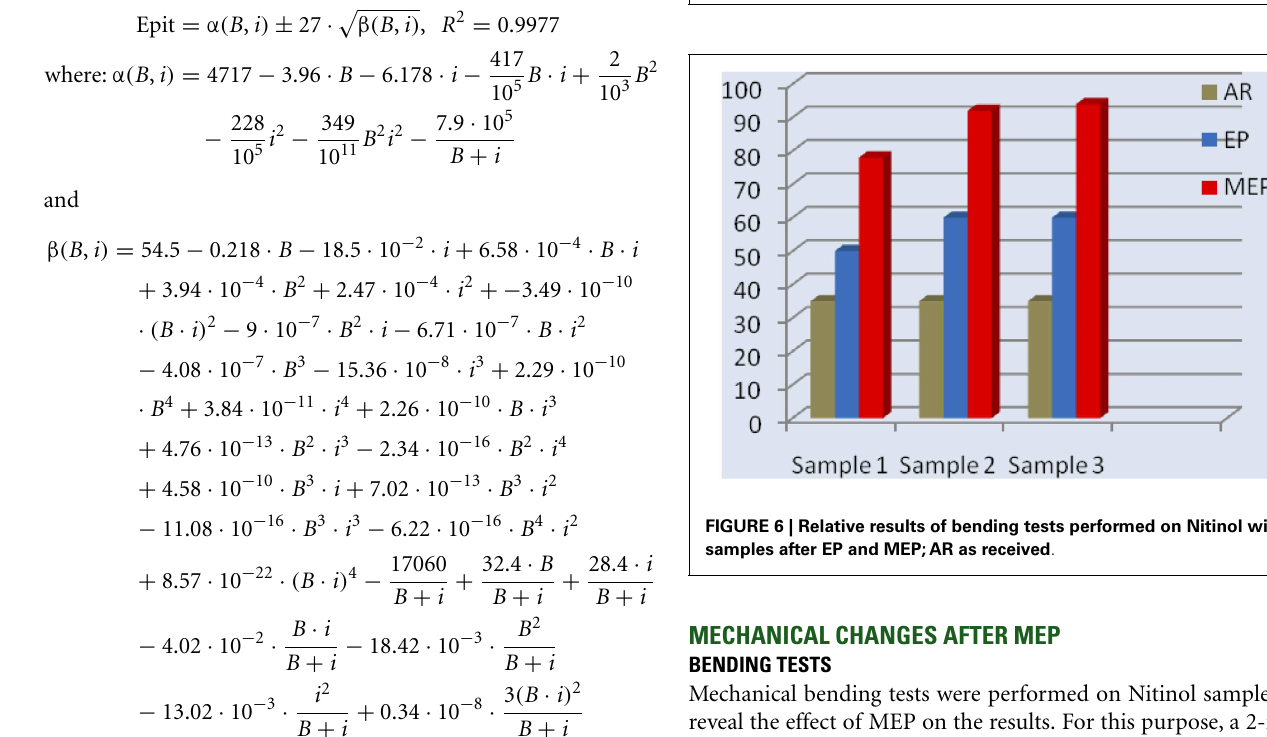
FIGURE 5 |TotalTi/Ni ratio contents comparison of NiTi endodontic files on surface:AR, as received (bulk/matrix data), EP, after a standard electropolishing, and MEP, after magnetoelectropolishing .